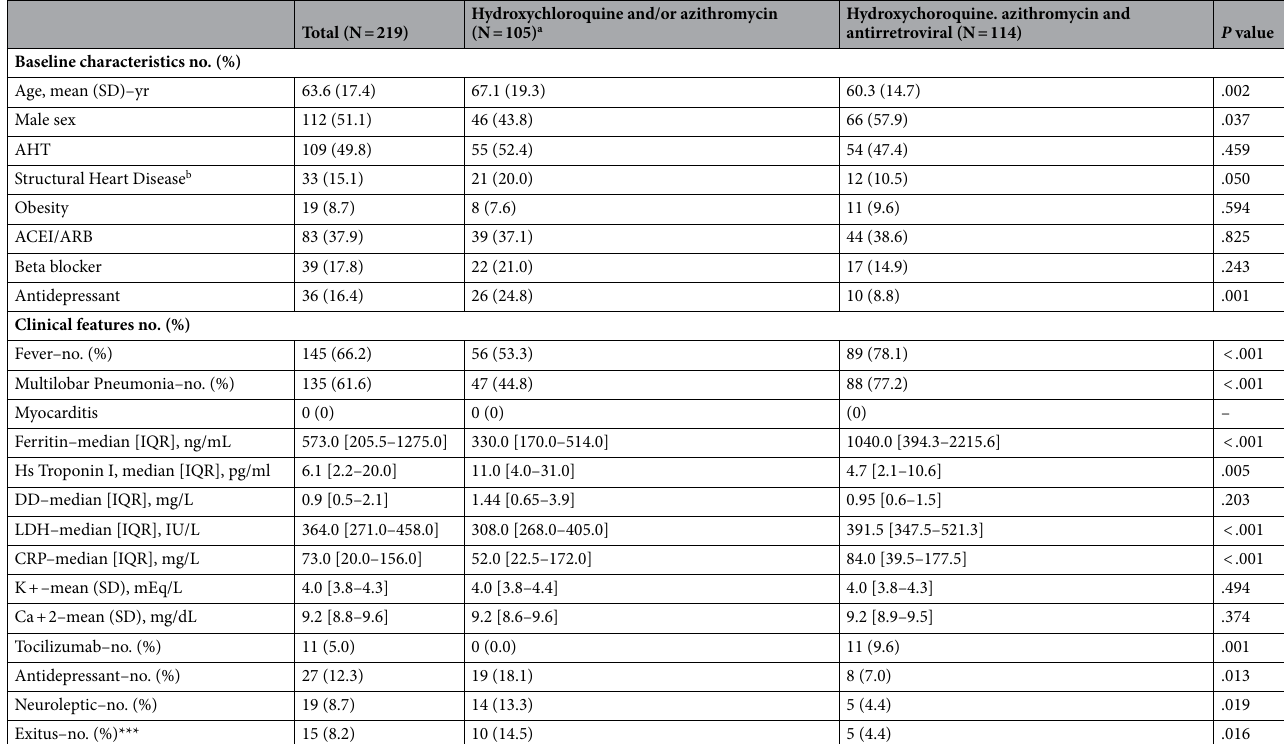
Table 1. Baseline and clinical characteristics depending of COVID-19 treatment administered. ACEI, angiotensin converting enzyme inhibitor; AHT, arterial hypertension ARB, angiotensin receptor blocker; CRP, C-reactive protein; DD, D-dimer; ECG, electrocardiogram; Hs, high sensitive; IQR, interquartile range; LDH, lactate dehydrogenase; SD, standard deviation. a Note that 90.5% (n = 95) of the patients received both drugs, azithromycin and hydroxychloroquine. b Considered: ischemic, hypertensive, dilated, hypertrophic and valvular cardiomyopathy. c Inpatient mortality (n =